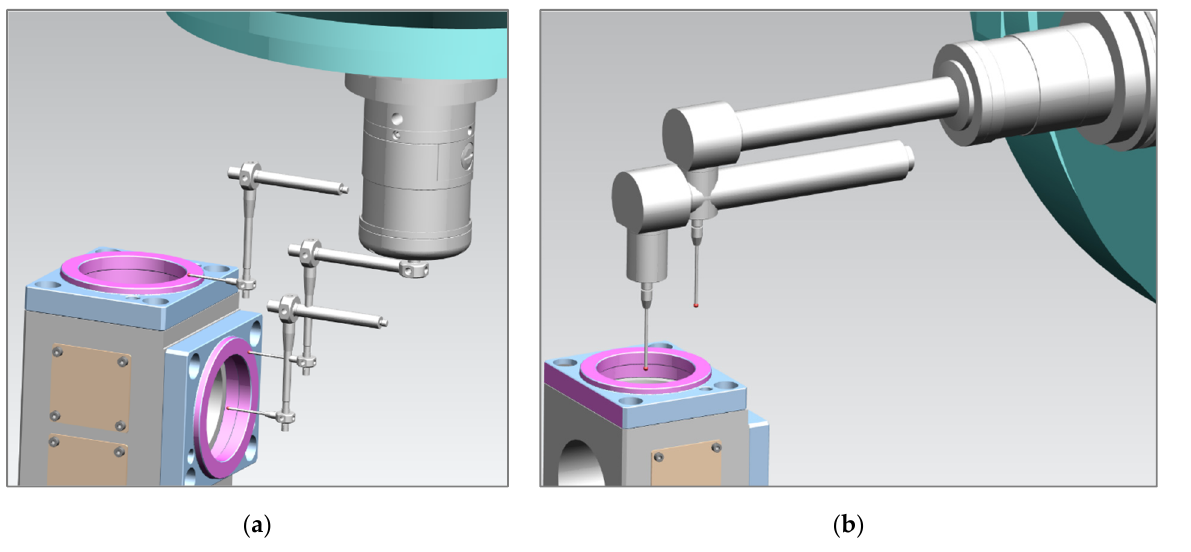
Figure 10. View of required B-axis tilting head position for measurement by special or custom probes: ( a ) T4 TTP position for P6/P5 area measurement with B 0° head position; ( b ) T6 TTP position for P5 area measurement with B 90° head position.